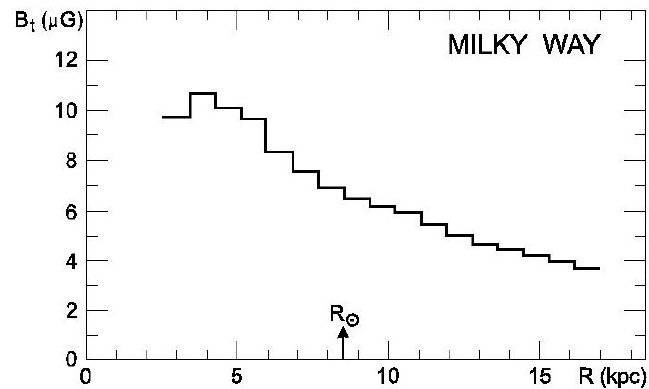
Figure 1. Radial variation of the total magnetic field in the Milky Way, estimated with the equipartition assumption from the data of the all-sky radio survey at 408 MHz [38]. The proton/electron ratio was assumed to be K = 100, the synchrotron spectral index α = 1.1 for 2.5 kpc < R < 6 kpc and α = 0.85 for R ≥ 6 kpc (from Elly M. Berkhuijsen , private